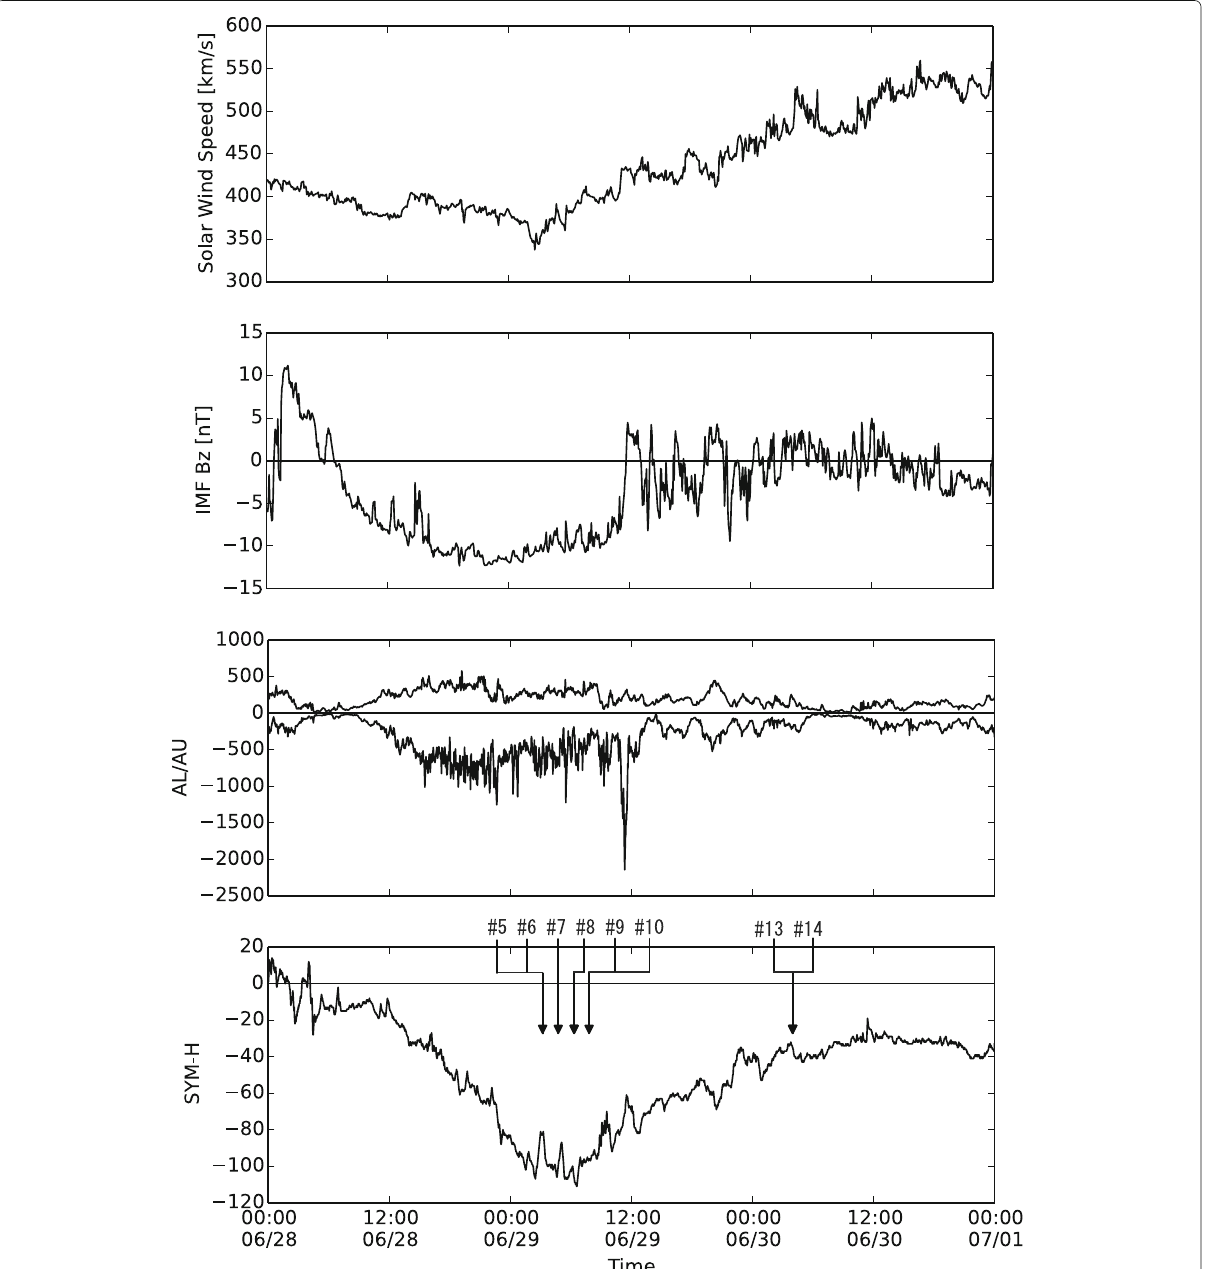
Fig. 6 The temporal variations of solar wind parameters and the geomagnetic index during 28–30 June 2013. From top to bottom, solar wind speed, IMF Bz, AU/AL index, and SYM-H index are shown. In the AU/AL index panel, the positive and negative values show the AU and AL index, respectively. In the bottom panel, the occurrence of EPBs listed in Table 2 are shown